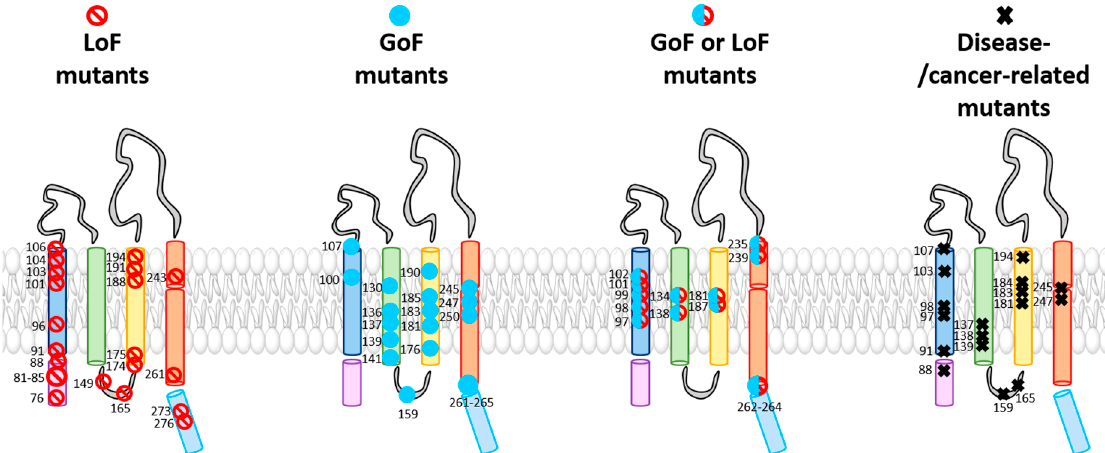
Figure 3. Orai1 mutations. The subunit schemes display so far discovered positions that, upon single substitution, lead to either LoF (indicated by red stop sign, left ) or GoF (visualized by blue circle, middle left ) mutations. The positions that, upon substitution to different residues, can lead to both GoF, i.e., Orai1 H134A, and LoF, i.e., Orai1 H134W, are represented ( middle right ). Disease-/cancer-related mutation positions are marked as black crosses ( right ).